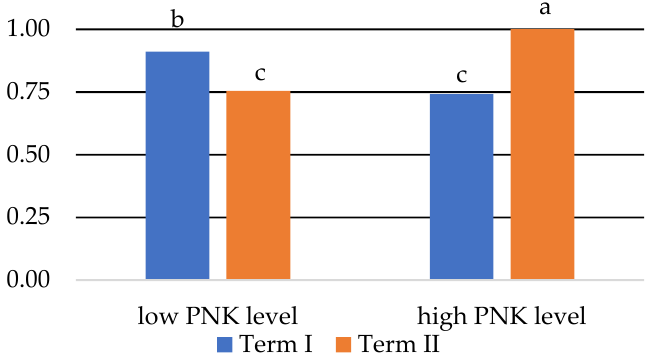
Figure 5. The tolerance index of Hydrocharis morsus-ranae in the three tested growing seasons. Similar letter indicates no significant difference ( p ≤ 0.05).